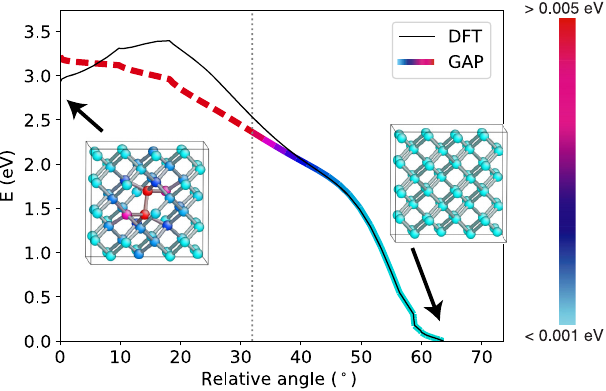
FIG. 23. Relaxation path of the GAP model showing the instability of the fourfold defect as a function of the angle of the rotating bond relative to its initial orientation. The left-hand side of the plot corresponds to the local minimum of the fourfold defect for the DFT model. The black curve shows the energy of the configurations of this path evaluated with the DFT (which is not a DFT minimum energy path but, of course, still shows a barrier). The thick curve shows the GAP model energies, colored according to the maximum per-atom predicted error of the GAP model and is dashed where the predicted error exceeds the scale maximum of 5 meV per